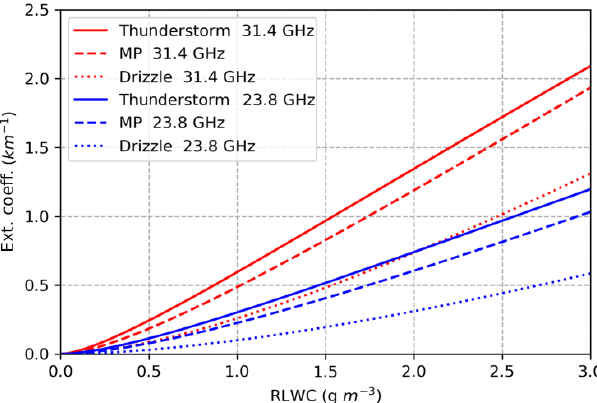
Figure C1. The extinction coefficient as a function of RLWC for precipitation with three different drop size distributions (DSDs), which are for heavy precipitation (thunderstorm), moderate precip- itation (MP), and drizzle precipitation